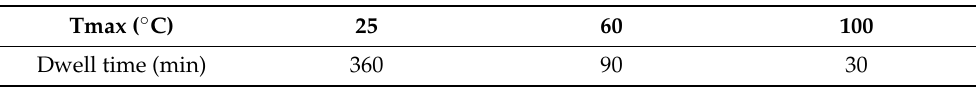
Table 3. Thermal cycle